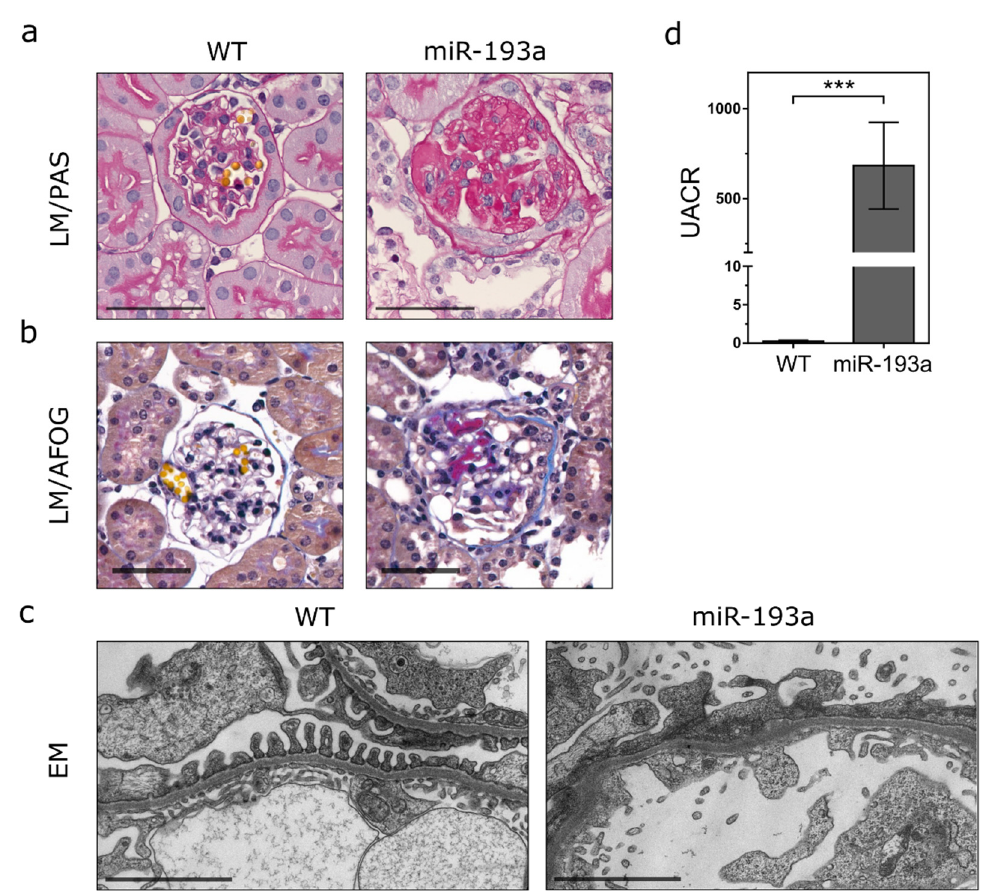
Figure 1. Kidney histology and albuminuria in miR-193a-driven focal segmental glomerulosclerosis (FSGS). Representative images of ( a ) Periodic-acid Schiff (PAS) and ( b ) trichromic Acid Fuchsin Orange G (AFOG) stainings of formalin-fixed paraffin-embedded (FFPE) sections show FSGS, intracapillary cast formation, and extracellular protein deposition in miR-193a mice 8 weeks post induction. ( c ) Electron-microscopy (EM) reveals podocyte foot process effacement, fusion, and detachment in miR-193a FSGS mice 8 weeks post induction of FSGS, but not wild-type control (WT). ( d ) Urinary albumin-to-creatinine ratio (UACR) in wild-type and miR-193a FSGS mice 8 weeks post induction is indicated in g/g. Light microscopy (LM) images scale bar = 100 µm; electron microscopy (EM) images scale bar = 2 µm; values represent means ± SD, n ≥ 5/group; unpaired two-tailed Student’s t-test ***: p < 0.0001.